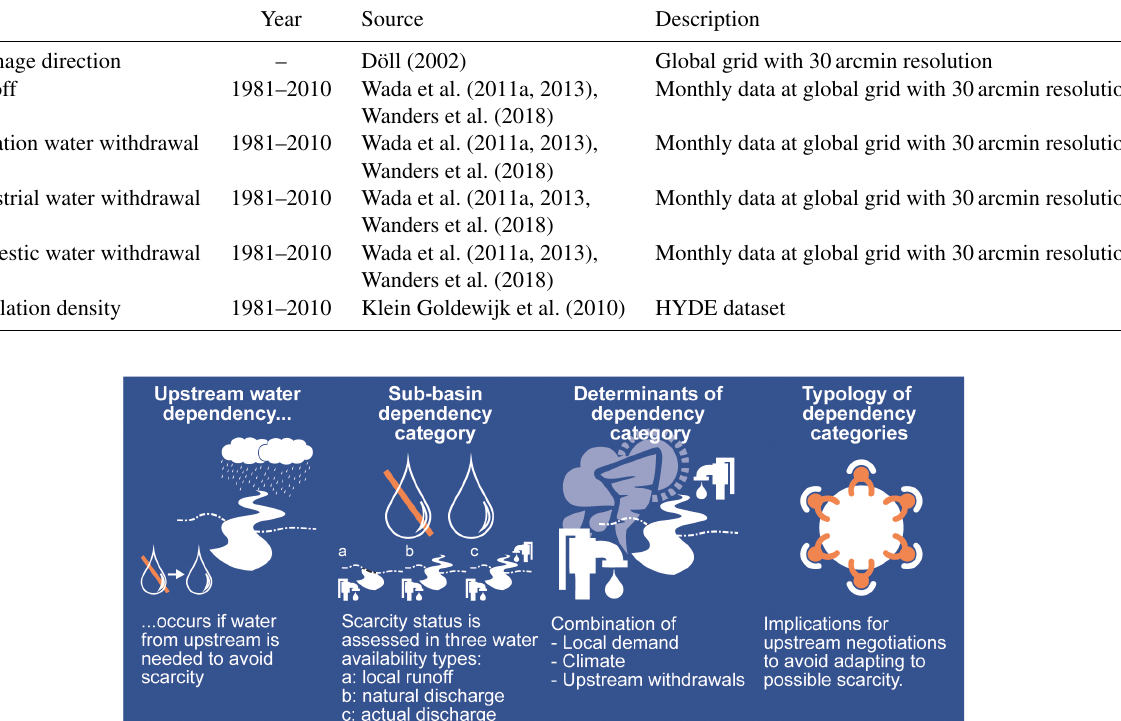
provide a first explanation of why dependency occurs.